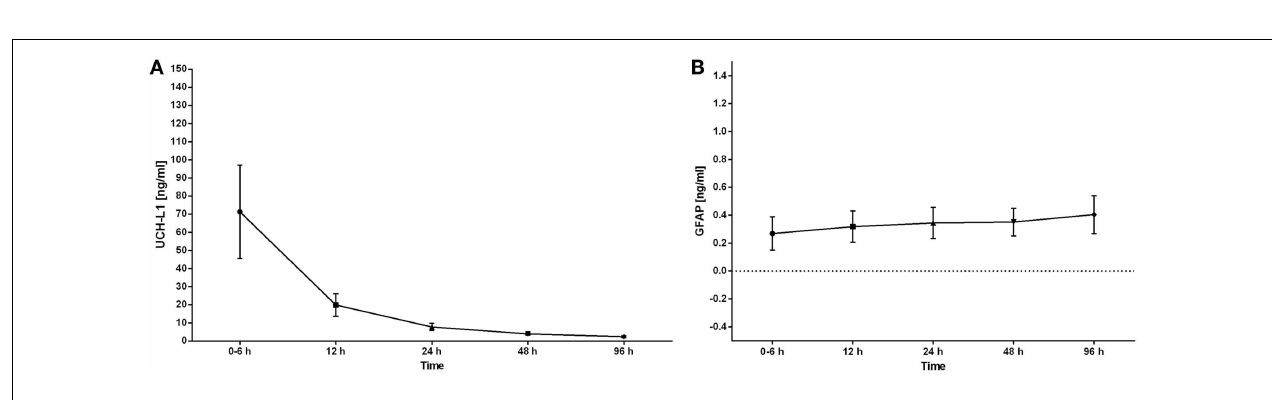
FIGURE 2 | Receiver–operator characteristic plots of UCH-L1 and GFAP at different time point in detecting HIE . Area under curve (AUC with 95% confidence interval) for UCH-L1 is 1.00, 0.83 (0.57–1.00), and 0.73